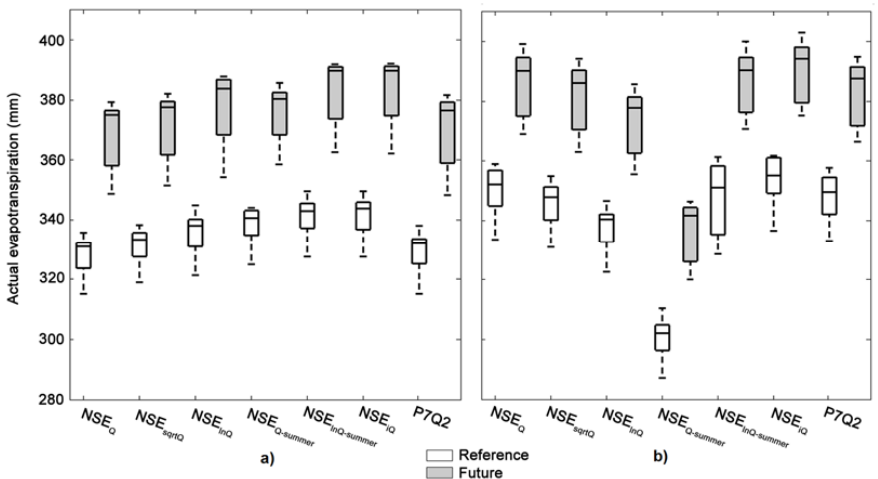
Figure 12. Sum of actual evapotranspiration simulated with the SWAT model for the summer (May to October) for the ( a ) Cowansville sub-watershed; and ( b ) Noire River sub-watershed.